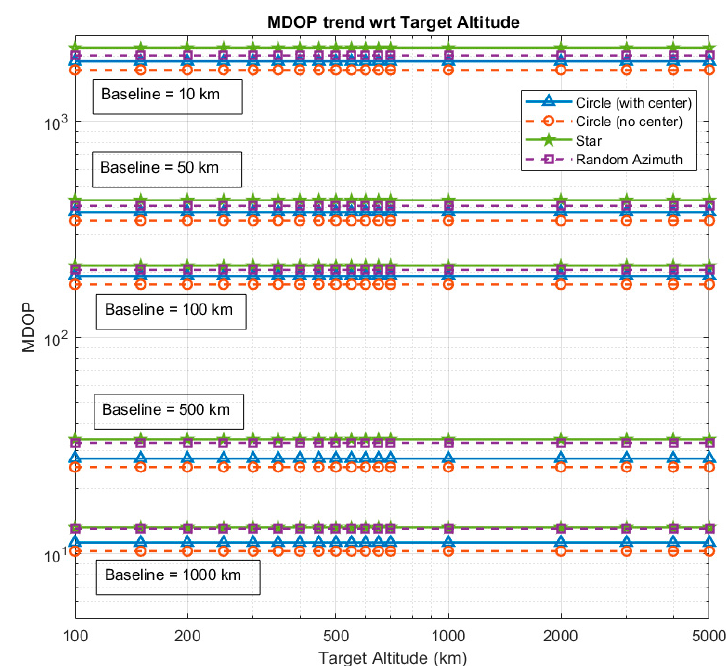
ff erent baseline values.